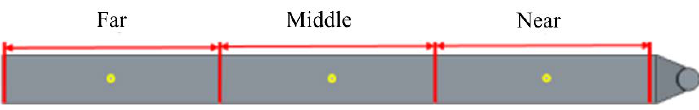
Figure 2. The strip model dimensions with a fan gate design.